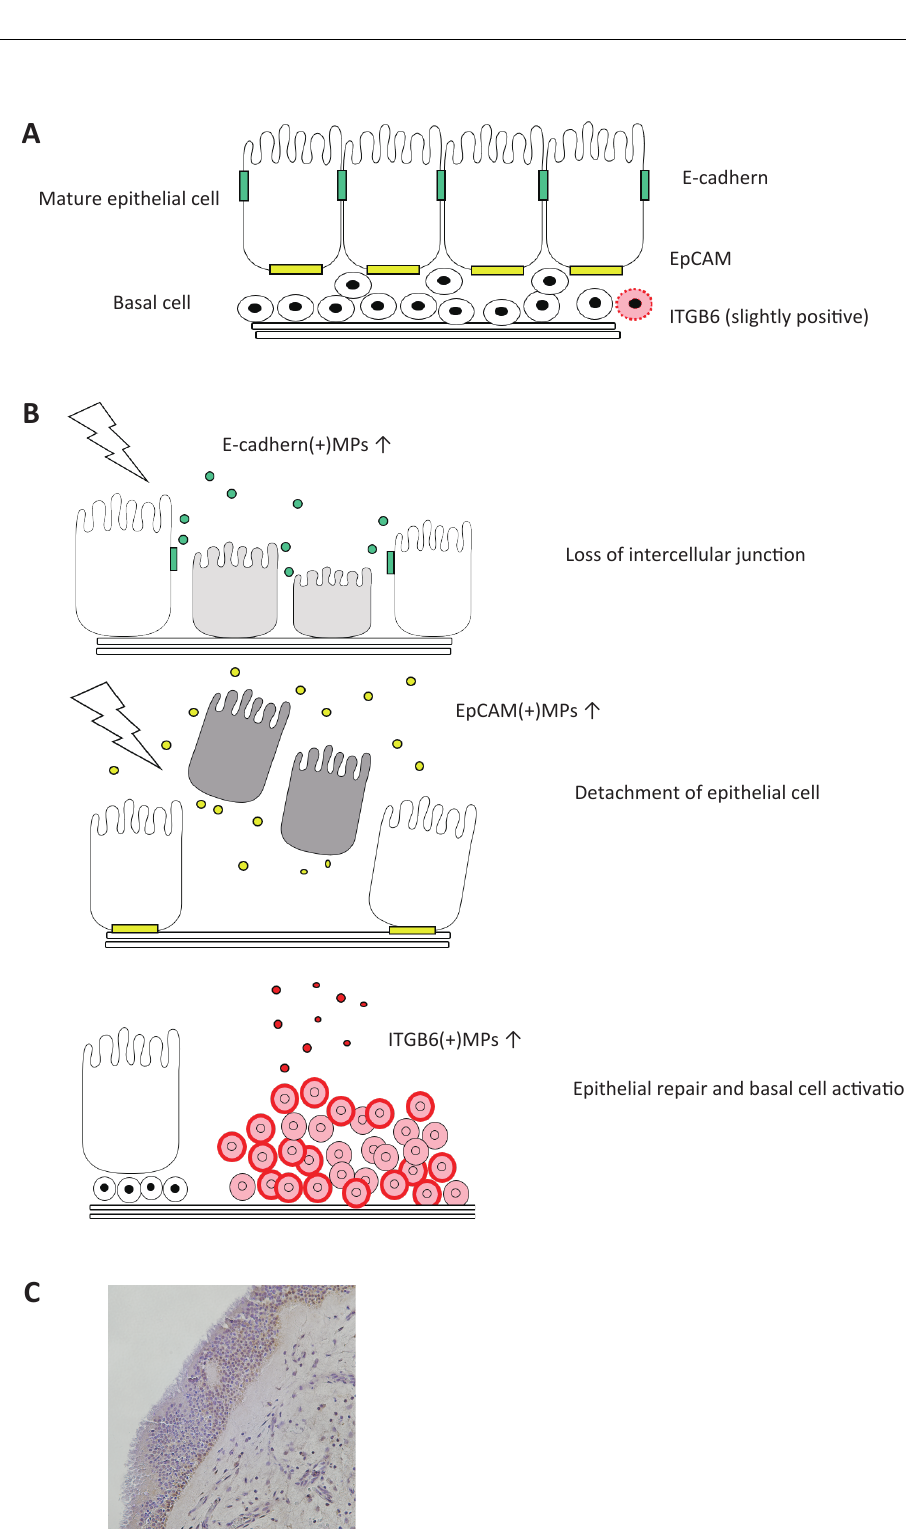
Figure 4. Location of epithelial markers and epithelial MP release. ( A ) Location of E-cadherin, Ep- CAM, and ITGB6. ( B ) Schematic of release of E-cadherin(+)MPs, EpCAM(+)MPs, and ITGB6(+)MPs. ( C ) Immunohistochemistry for ITGB6 in sinonasal uncinated tissue from CRSwNP. A representative image under 40 × magnification is shown. ITGB6 was positive on hyperplastic basal cells on injured epithelium, perhaps indicative of